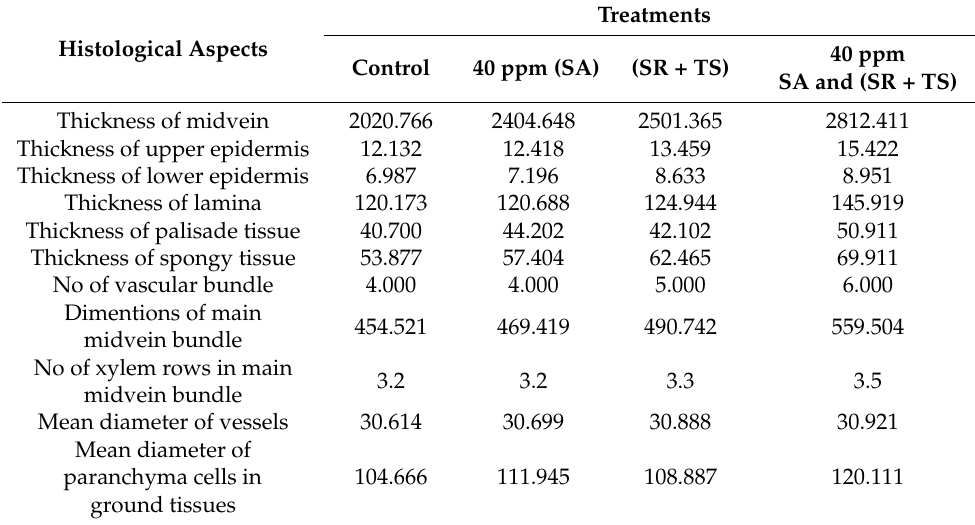
Table 7. Counts and measurements in micrometers ( µ m) of certain histological characters in trans- verse sections through the blade of the fifth leaf developed on the main stem of summer squash